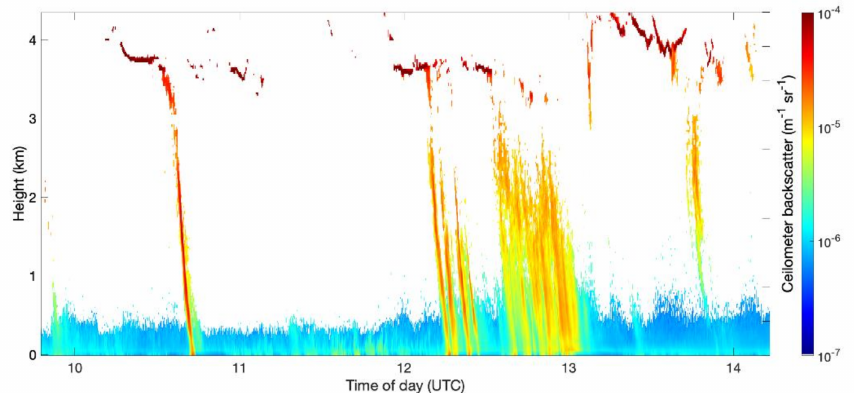
Figure 3. Detail of Figure 2b showing ceilometer backscatter during successive rain generating events between 1000 and 1400 UTC on 15 March 2019, highlighting instances of precipitation (e.g., ~1045 UTC) and virga (e.g., ~1345